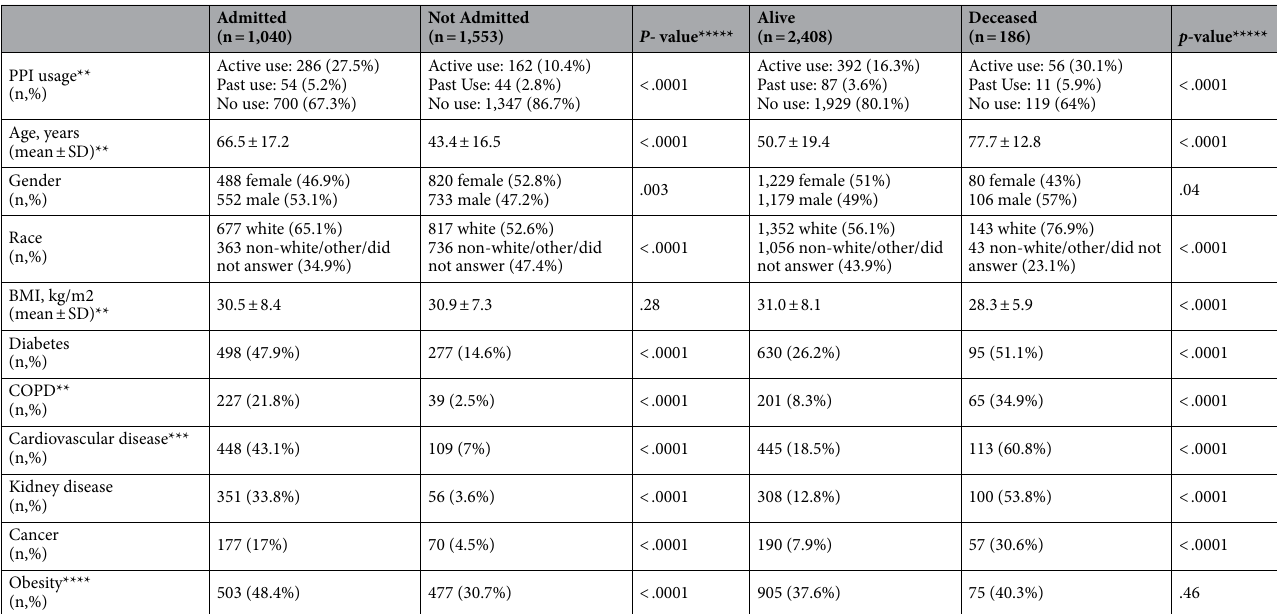
Table 2. Unadjusted comparisons for hospital admission within two weeks of COVID testing and for overall 30-day mortality *. *Denominators differ for some variables due to missing data. ** PPI Proton pump inhibitor, SD Standard deviation, COPD Chronic obstructive pulmonary disease. ***Cardiovascular disease is a composite of cardiomyopathy, congestive heart failure, and coronary artery disease. ****Defined as BMI > 30 kg/m2. *****Based on separate one-way analysis of variance or chi square tests,